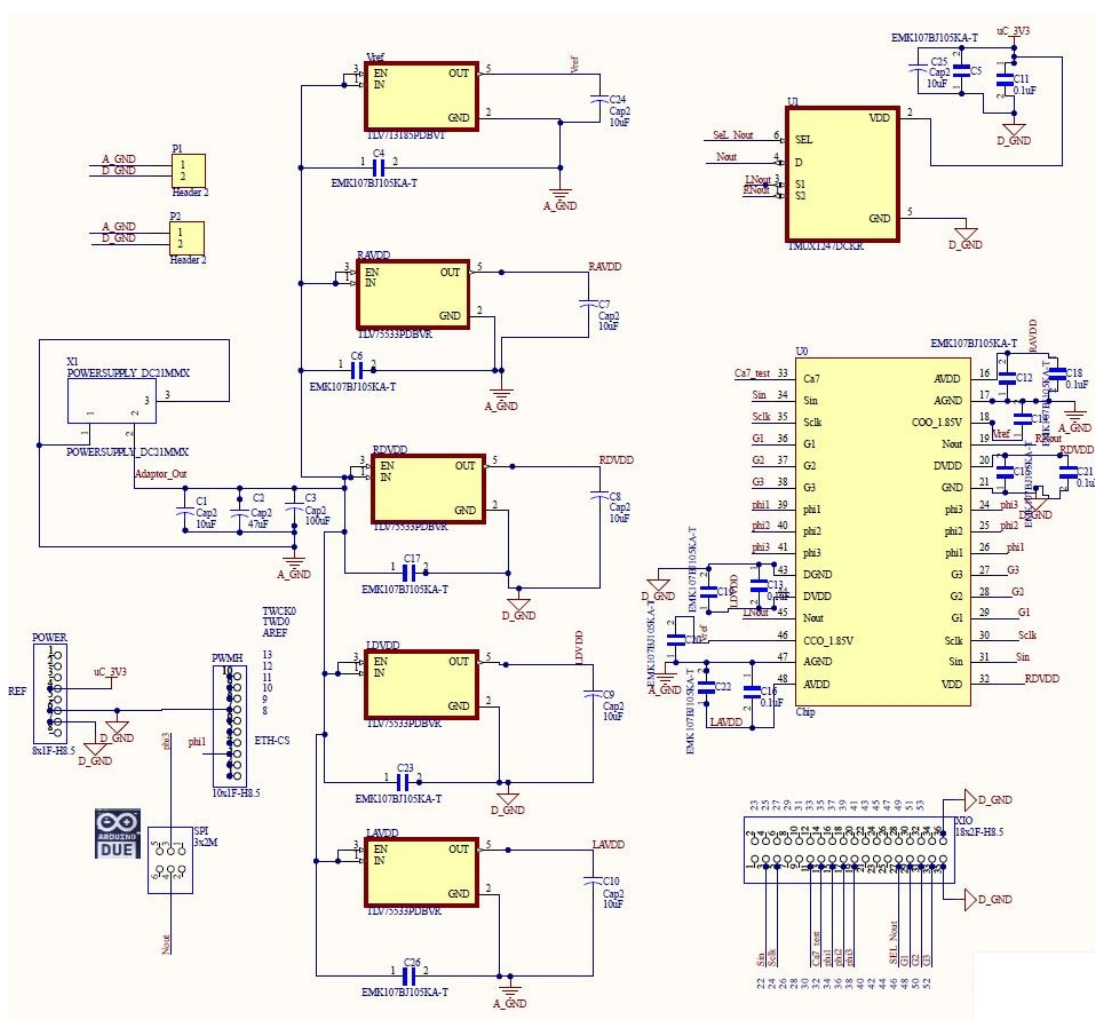
Figure A1. The schematic of the PCB of the sensor shown in Figure 9.